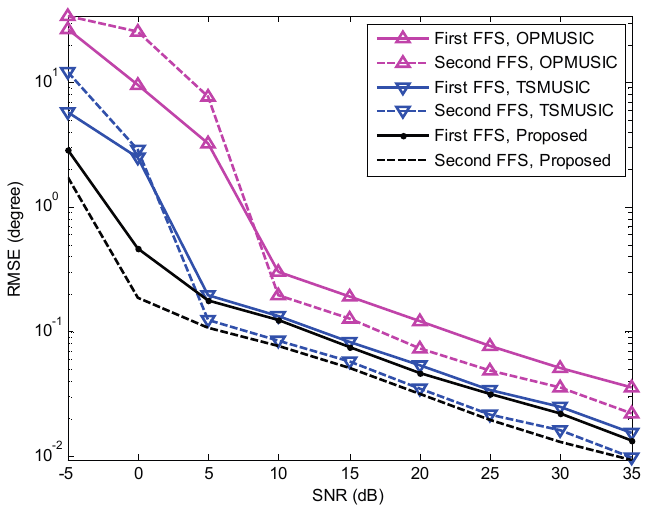
Figure 6. RMSEs of far-field sources (FFSs) DOA estimates versus SNR.